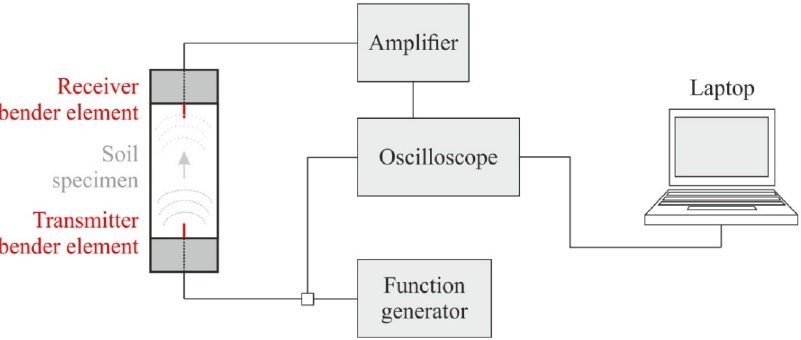
Figure 3. Bender element test set ‐ up within a triaxial device (modified according to [54]).